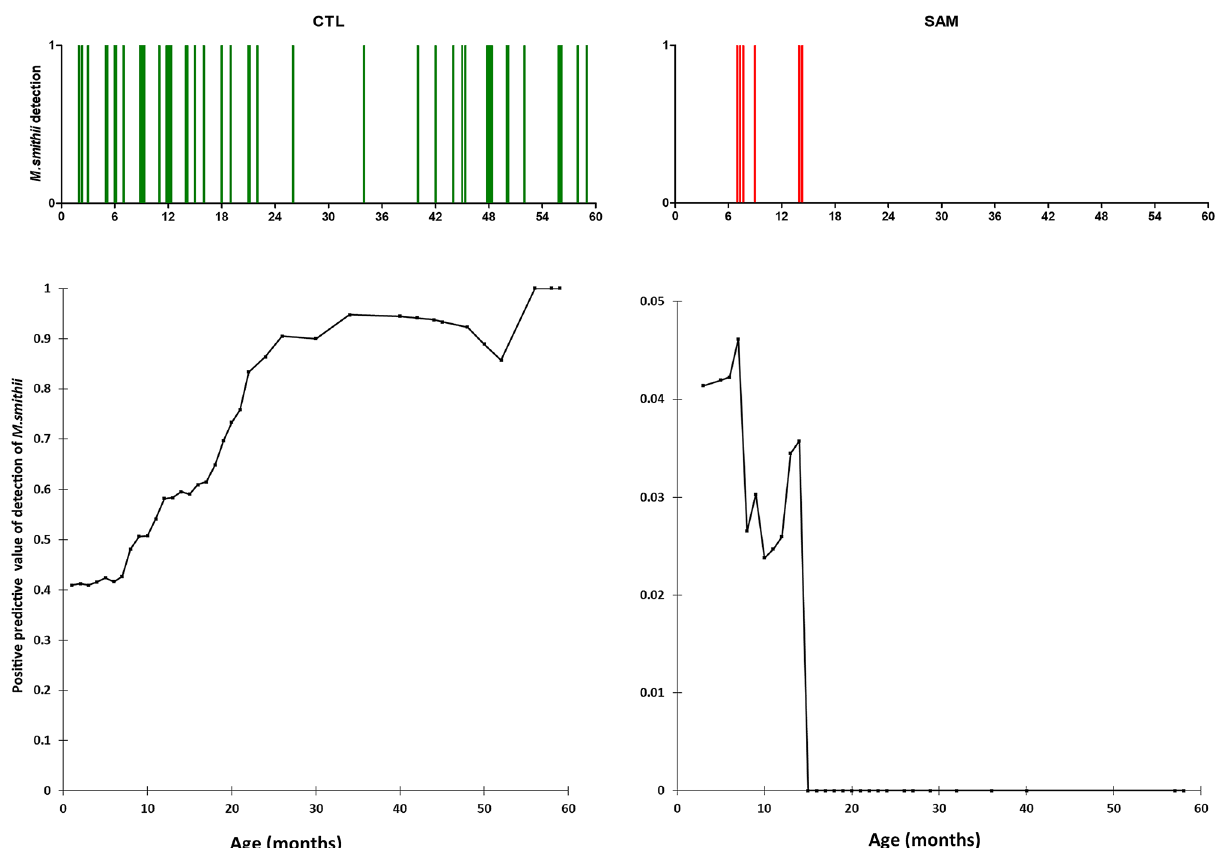
Figure 4. Positive predictive value of Methanobrevibacter smithii in healthy and malnourished children according to age. Probability of detection of M. smithii relating to age is shown in healthy controls (CTL) and severely malnourished children (SAM); spike bars represent all the individuals from whom M. smithii has been detected in each group in the age range from 0 to 59 months. Green spike bars represent healthy controls children in top with the associated predictive value below. Red spike bars represent cases with the associated predictive value